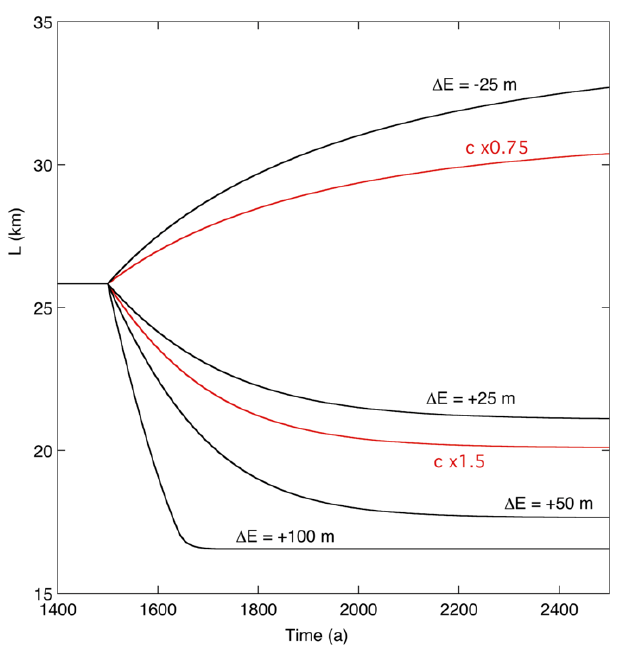
Figure 5. Evolution of glacier length for different perturbations of the ELA ( (cid:49)E ) and different values of the calving parameter c .